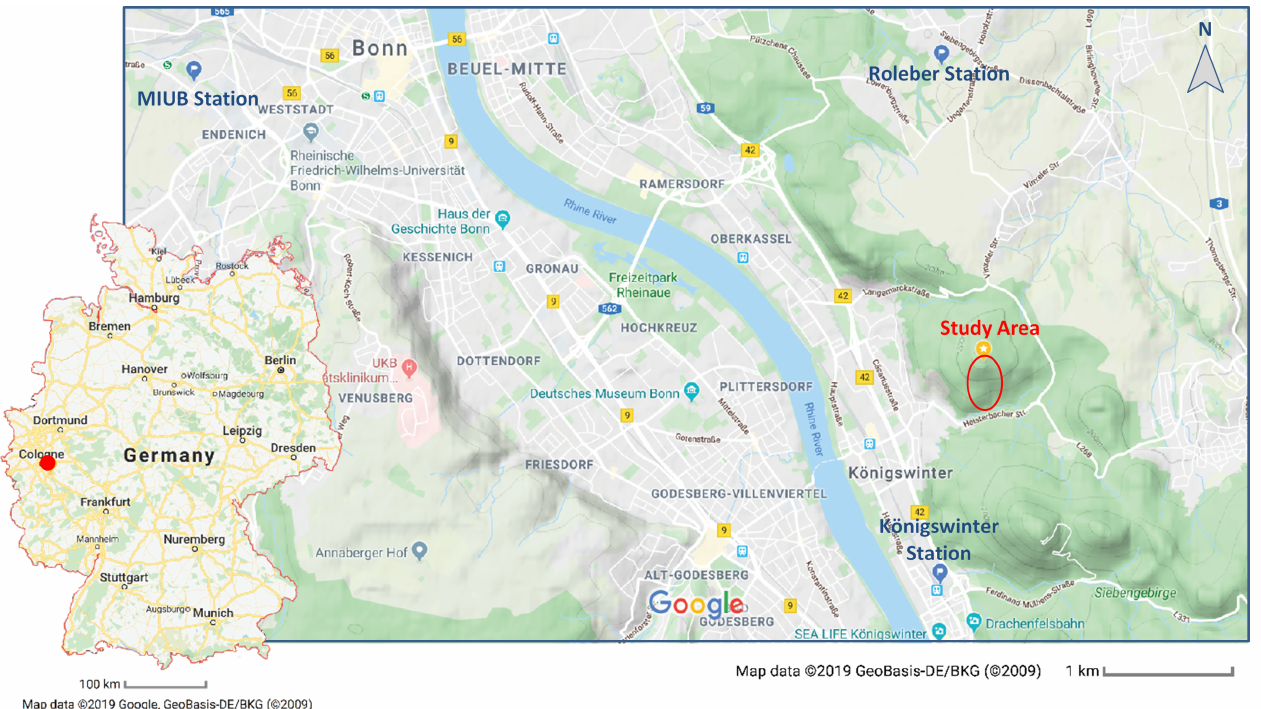
Figure 1. Location of the study site near Bonn, Germany (source: Google